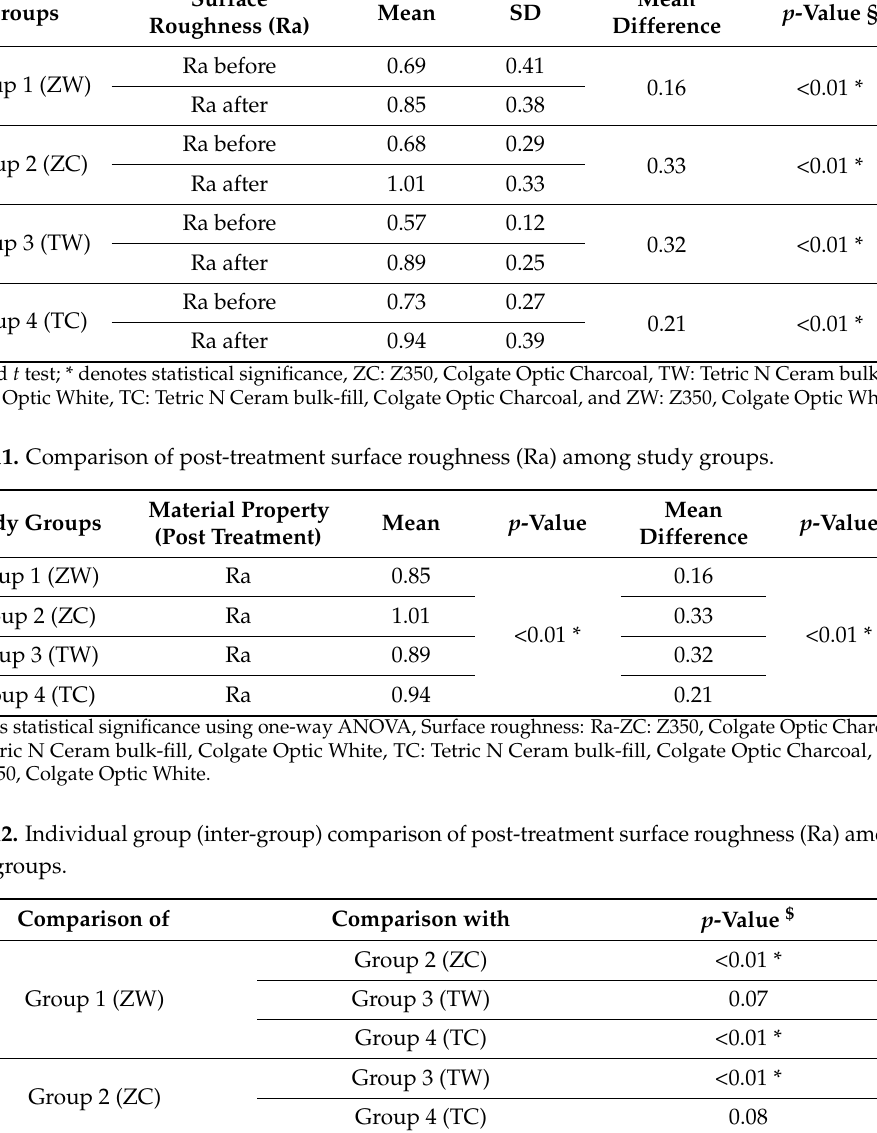
Table 10. Comparison of mean surface roughness (Ra) before and after treatments among study groups. Groups